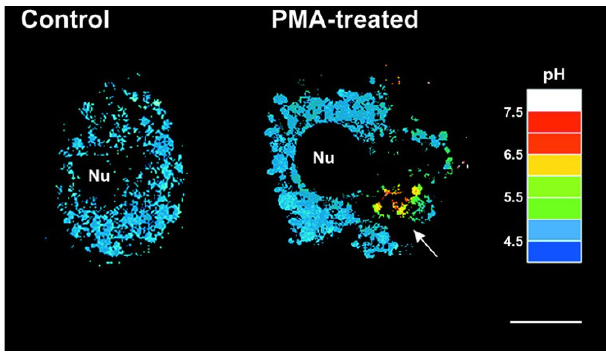
Figure 4 PMA treatment increases pH to 6.5–7.5 in a subset of lysosomes. Lysosomal pH in untreated cells is below 4.5 as shown on the left image. In PMA-treated cells, pH was signif- icantly elevated to as high as 6.5–7.5 in only a subset of lyso- somes as indicated by the arrow, while the pH of other lysosomes were essentially unaffected. Nu, nucleus. Bar, 10 µ